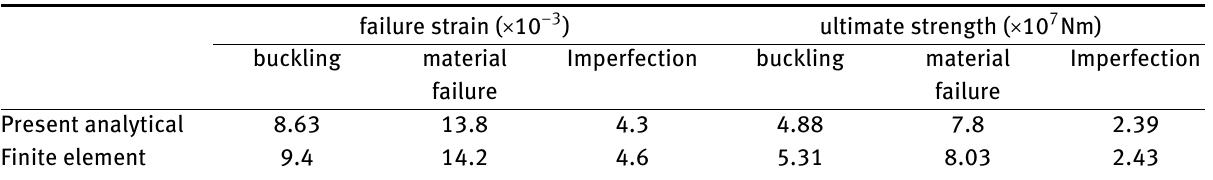
Table 5: Results of failure strain and ultimate strength